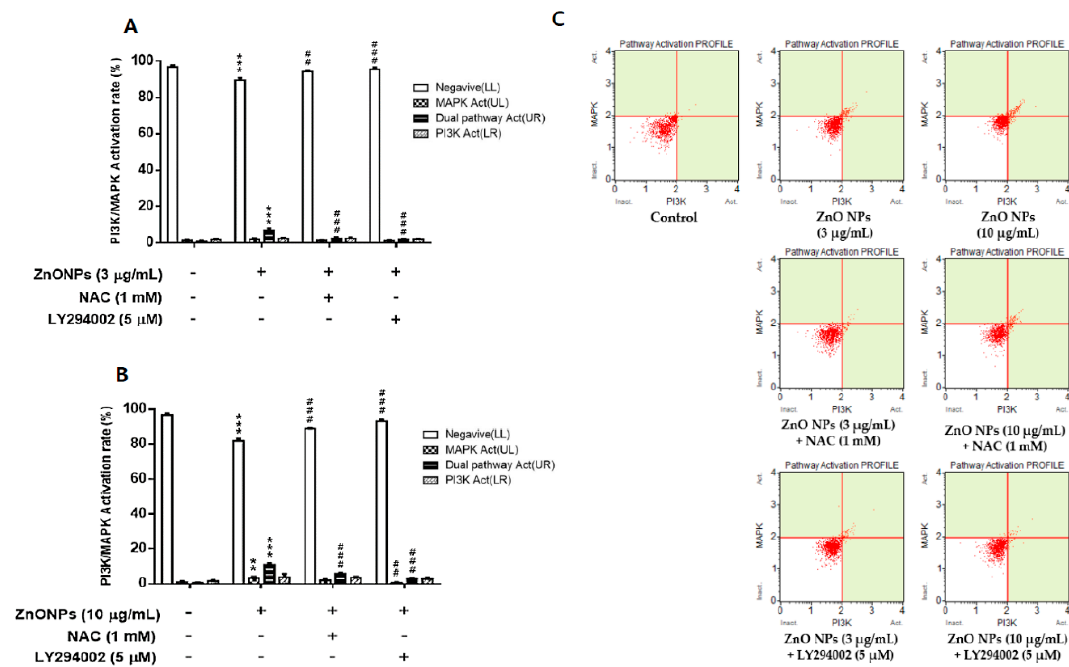
Figure 7. E ff ect of ZnO NPs on activation of the phosphatidylinositol 3-kinase (PI3K) / mitogen-activated Figure 7. Effect of ZnO NPs on activation of the phosphatidylinositol 3-kinase (PI3K)/ protein kinase (MAPK) dual pathway in primary cultured astrocyte cells. ZnO NPs significantly mitogen-activated protein kinase (MAPK) dual pathway in primary cultured astrocyte cells. ZnO increased PI3K / MAPK dual pathway activation at 3 µ g / mL ( A ) and 10 µ g / mL ( B ). NAC and LY294002 NPs significantly increased PI3K/MAPK dual pathway activation at 3 μ g/mL ( A ) and 10 μ g/mL ( B ). significantly inhibited PI3K / MAPK dual pathway activation. Representative flow cytometry data for NAC and LY294002 significantly inhibited PI3K/MAPK dual pathway activation. Representative the control, ZnO NPs (3 and 10 µ g / mL), ZnO NPs (3 or 10 µ g / mL) + NAC, and ZnO NPs (3 or 10 µ g / mL) flow cytometry data for the control, ZnO NPs (3 and 10 μ g/mL), ZnO NPs (3 or 10 μ g/mL) + NAC, + LY294002 (5 µ M) at 12 h are illustrated in ( C ). Data represents the mean ± SEM. ** p < 0.01, *** p < and ZnO NPs (3 or 10 μ g/mL) + LY294002 (5 μ M) at 12 h are illustrated in ( C ). Data represents the 0.001 compared to the respective controls. ## p < 0.01, ### p < 0.001 compared to 3 or 10 µ g / mL ZnO mean ± SEM. ** p < 0.01, *** p < 0.001 compared to the respective controls. ## p < 0.01, ### p < 0.001 NPs ( n =